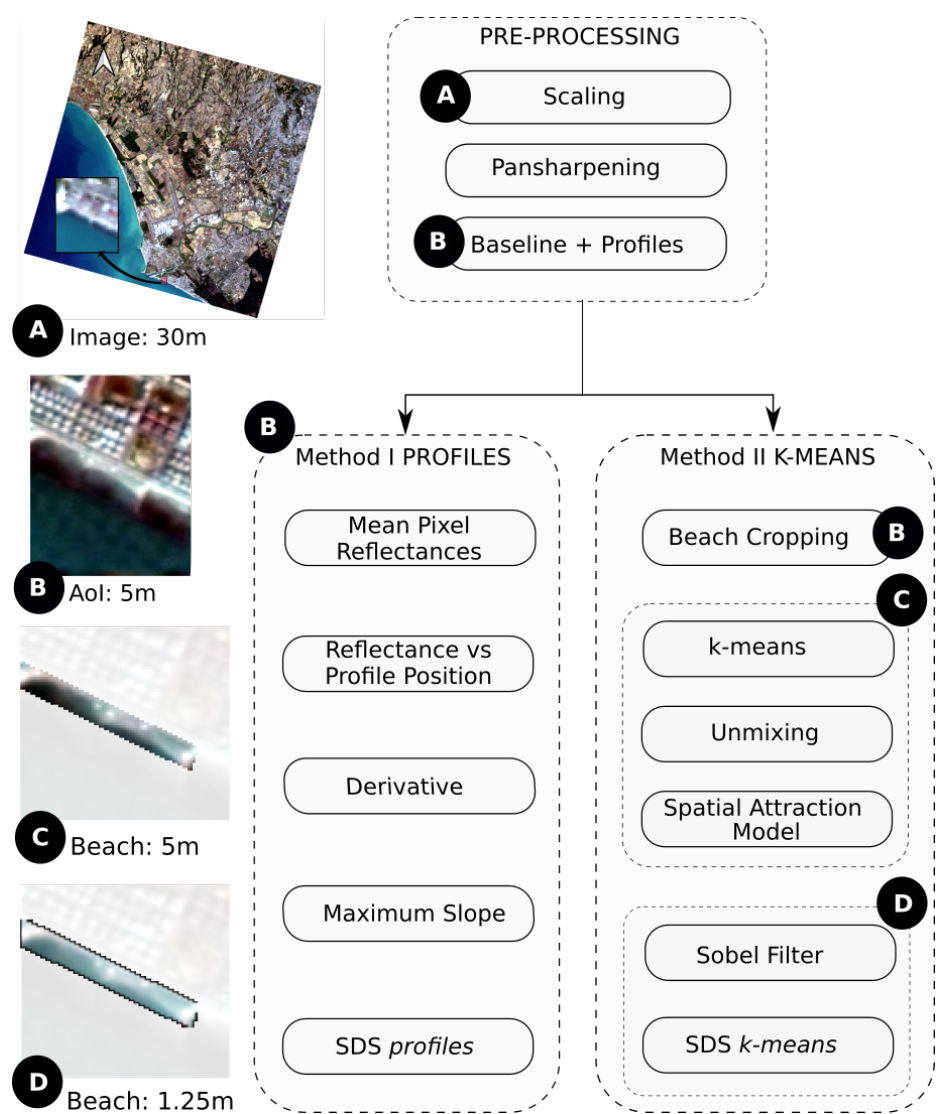
Figure 1. Schematic workflow for shoreline detection. The insets on the left (listed as ( A – D ) illustrate the image domains and spatial resolutions used in the different steps of the workflow. Preprocess- ing, Method I and Method II. Each block contains the steps, indicating on which image each step is